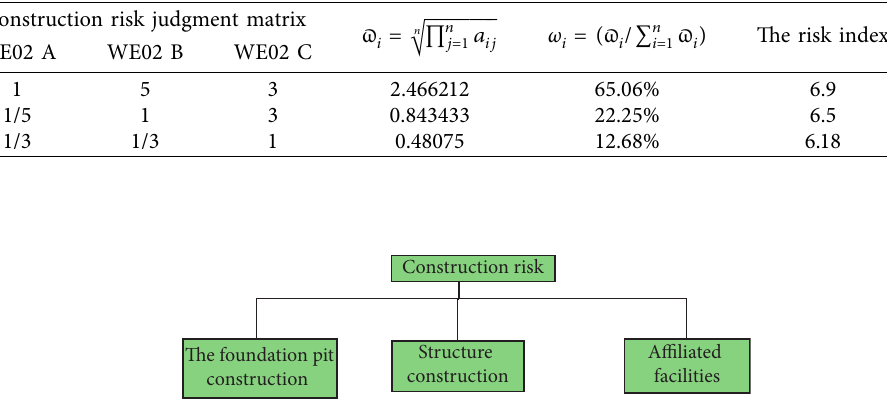
Table 37: Construction risk judgment matrix.